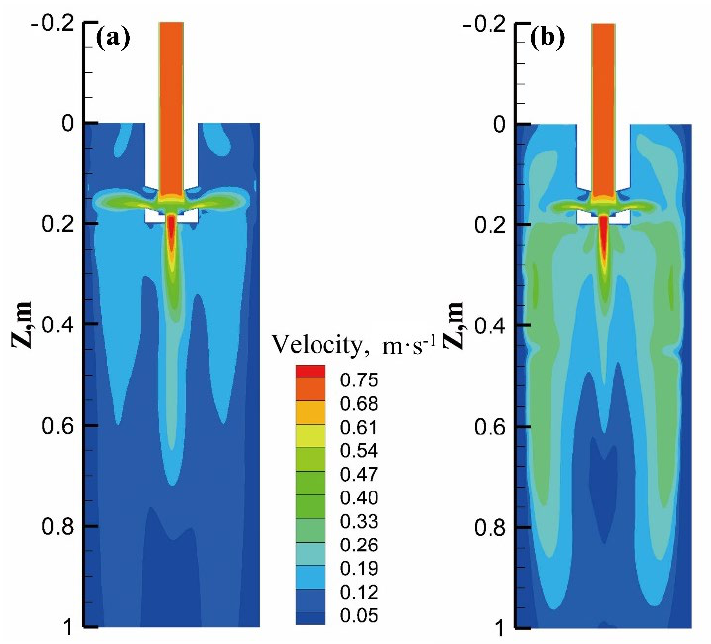
Figure 17. Velocity contour of the neutral plane of the side port under eccentric stirring of Φ 350 mm section: ( a ) 280 A; ( b ) 480 A.